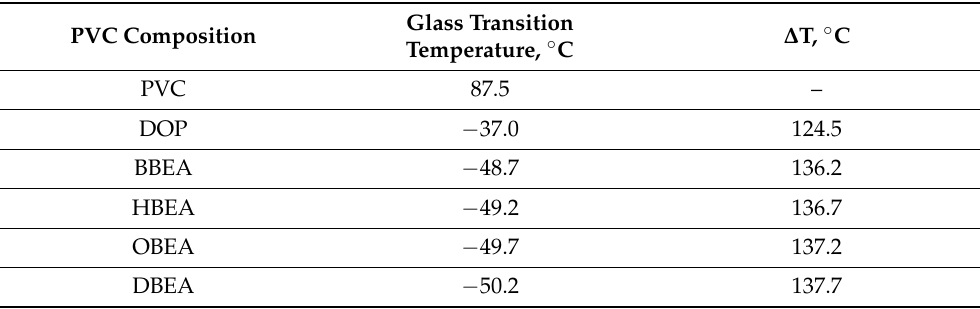
Table 3. Results of determining the phytotoxicity of alkyl butoxyethyl